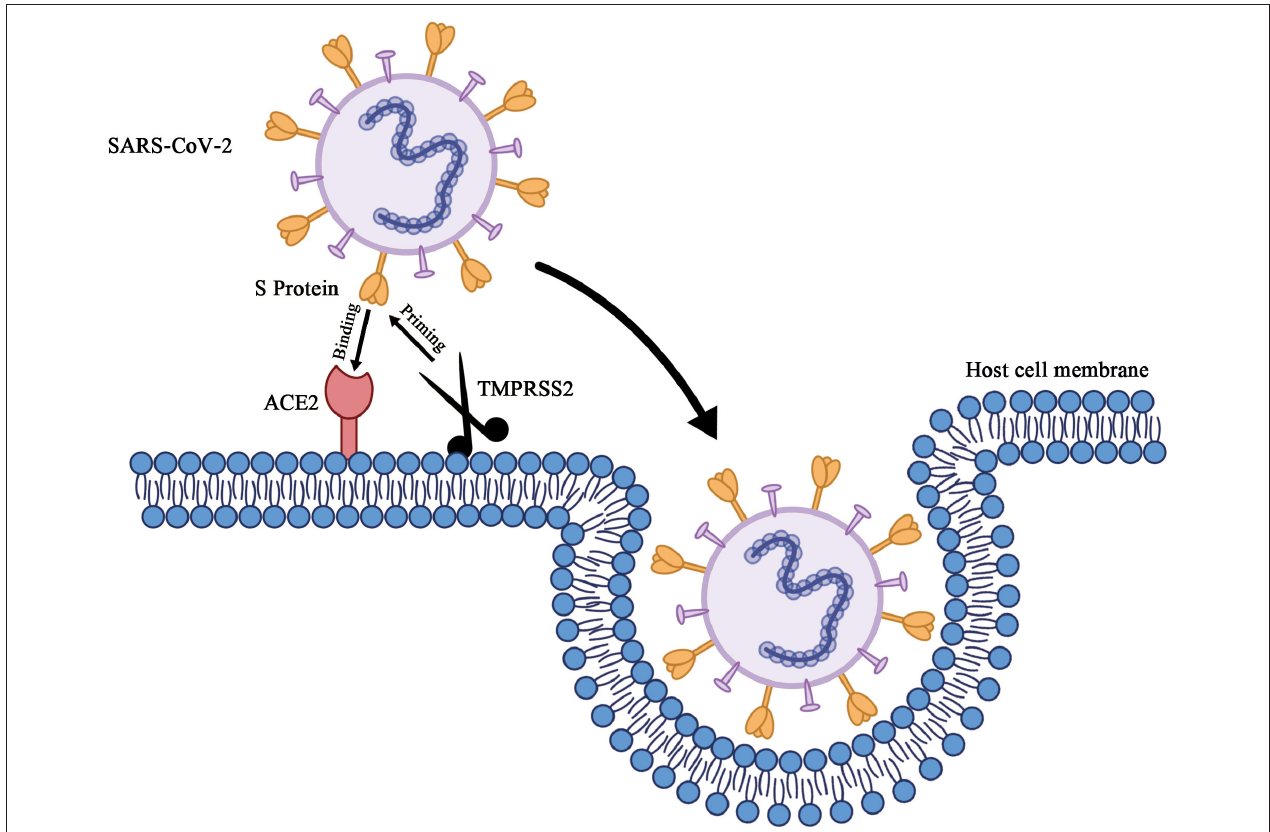
FIGURE 1 | Schematic of cell entry of SARS-CoV-2. When the trimeric S proteins of SARS-CoV-2 binds to the cellular receptor ACE2, the cellular serine protease TMPRSS2, which’s for S protein priming, entails S protein cleavage at the S1/S2 and the S2’ site to facilitates fusion of viral envelop and host cell